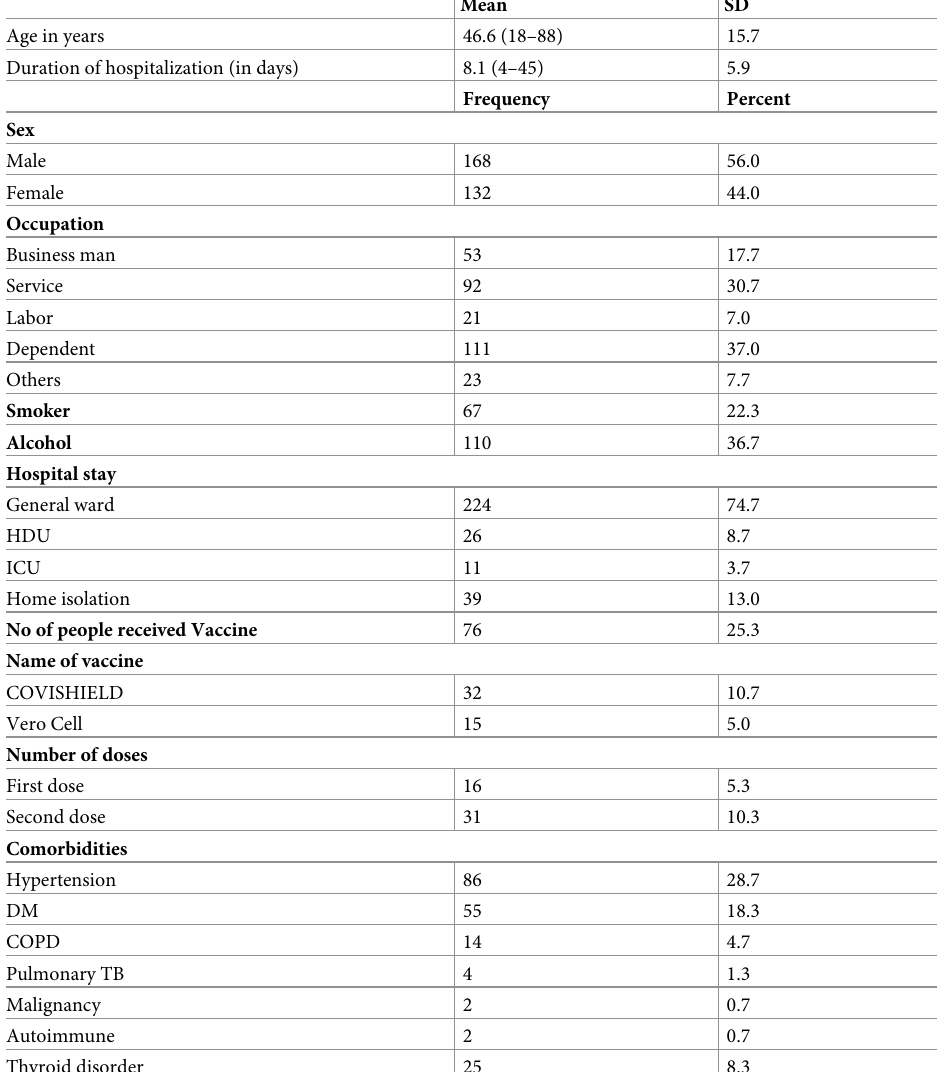
Table 1. Socio-demographic profile of included